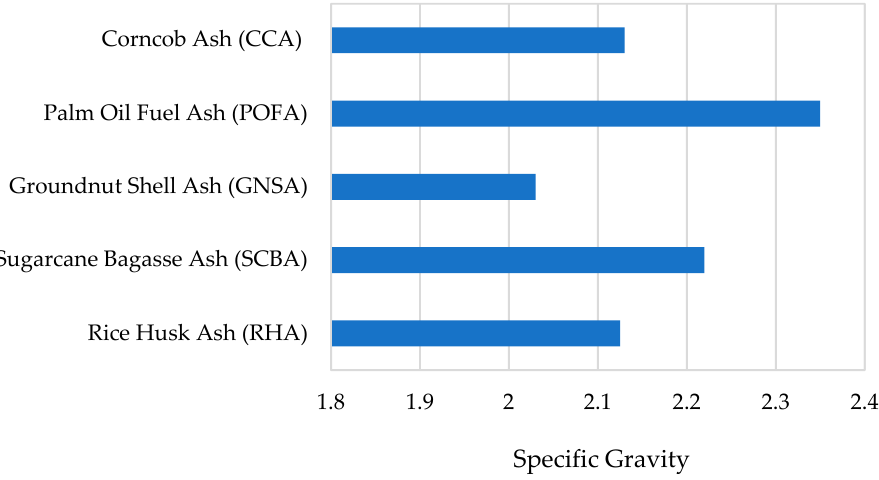
Figure 9. Specific gravity of agricultural waste ash. Table 9. Chemical composition of agricultural waste ash.